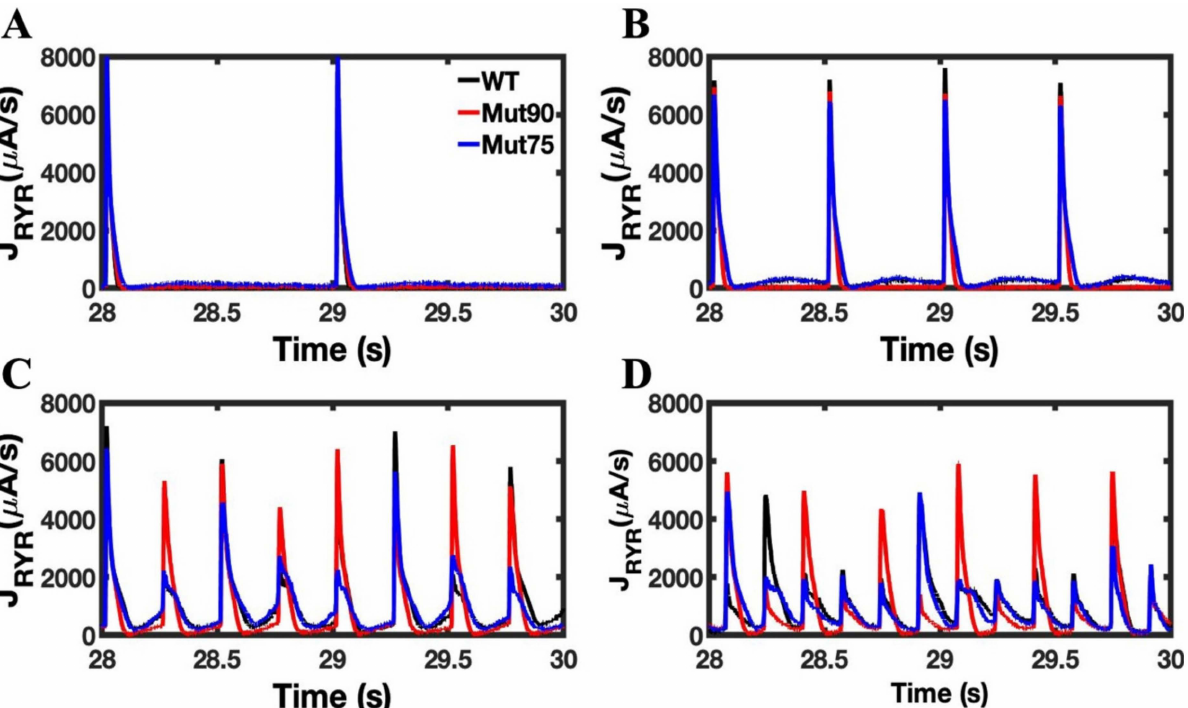
Figure 14. Flux through RYR2 channels in cardiac myocyte simulations under beta-adrenergic stimulation: ( A ) 1 Hz pacing, ( B ) 2 Hz pacing, ( C ) 4 Hz pacing, ( D ) 6 Hz pacing. The wild-type cardiac myocytes (black) show consistent morphology with increased pacing. The mutant simulations CDI (75% of transition rate—blue and 90% of transition rate—red) of the cardiac myocyte show that the total calcium flux released through the RYR2 channels of 20,000 CRUs displays an increase in calcium sparks during beta-adrenergic stimulation. An additional increase in the open probability of RYRs comes from the higher calcium concentration in the dyadic subspace from their prolonged APD. Shown are representative simulations out of six repeated simulations with different random number seed values in each case. The different simulation traces for each condition overlap at steady-state pacing.